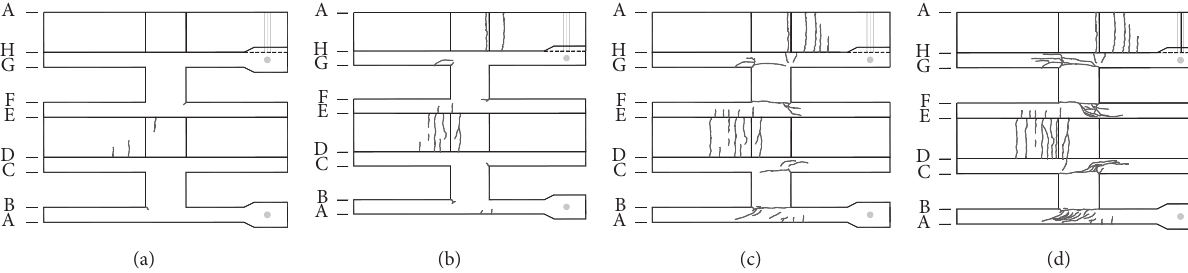
Figure 12: Cracking diagram of fracture development process. Crack distribution under (a) loading at 35%, (b) loading at 55%, (c) loading at 75%, and (d) under loading at the failure load.